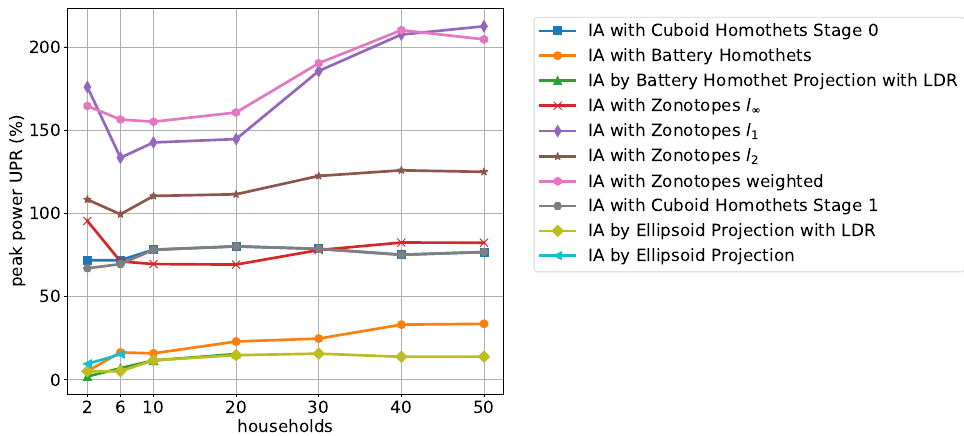
Figure 12. Peak power UPR for an increasing number of households and 12 time periods.